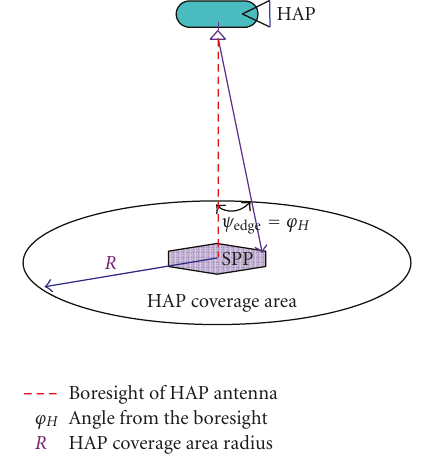
Figure 3: HAP antenna beamwidth definition.